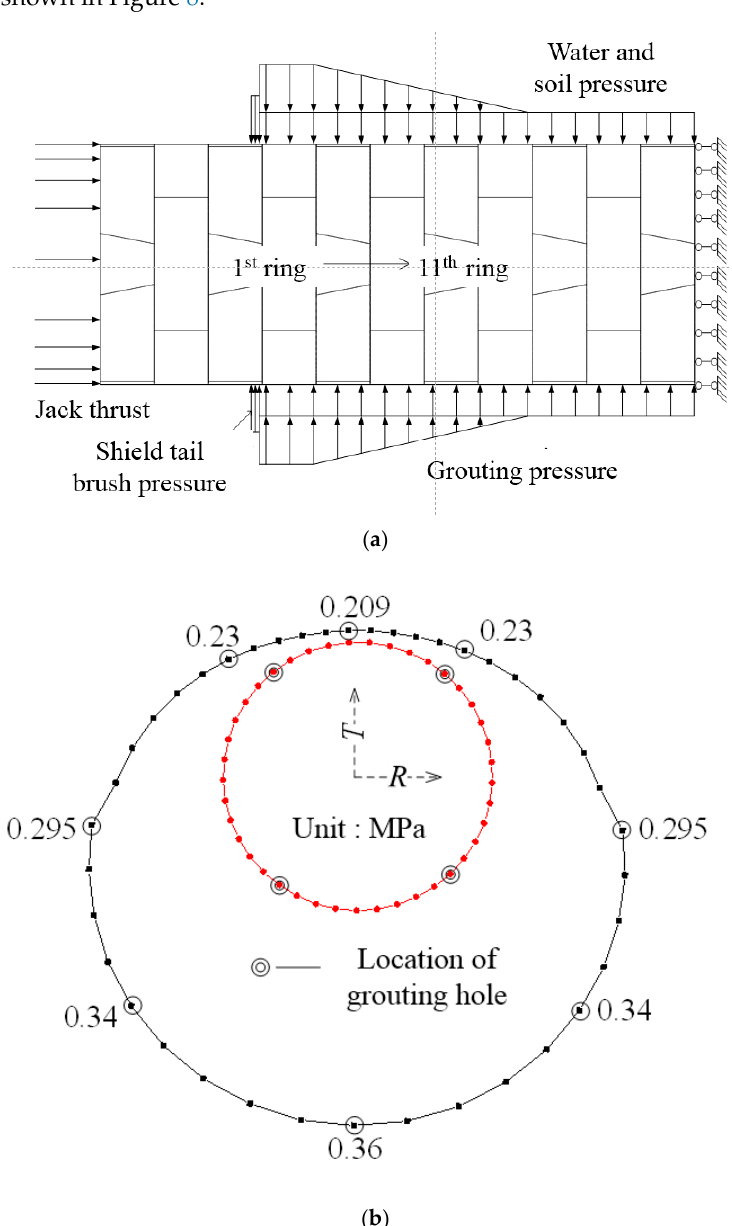
Figure 8. Grouting pressure distribution. ( a ) Longitudinal distribution pattern of grouting pressure. ( b ) Circumferential distribution pattern of grouting pressure.